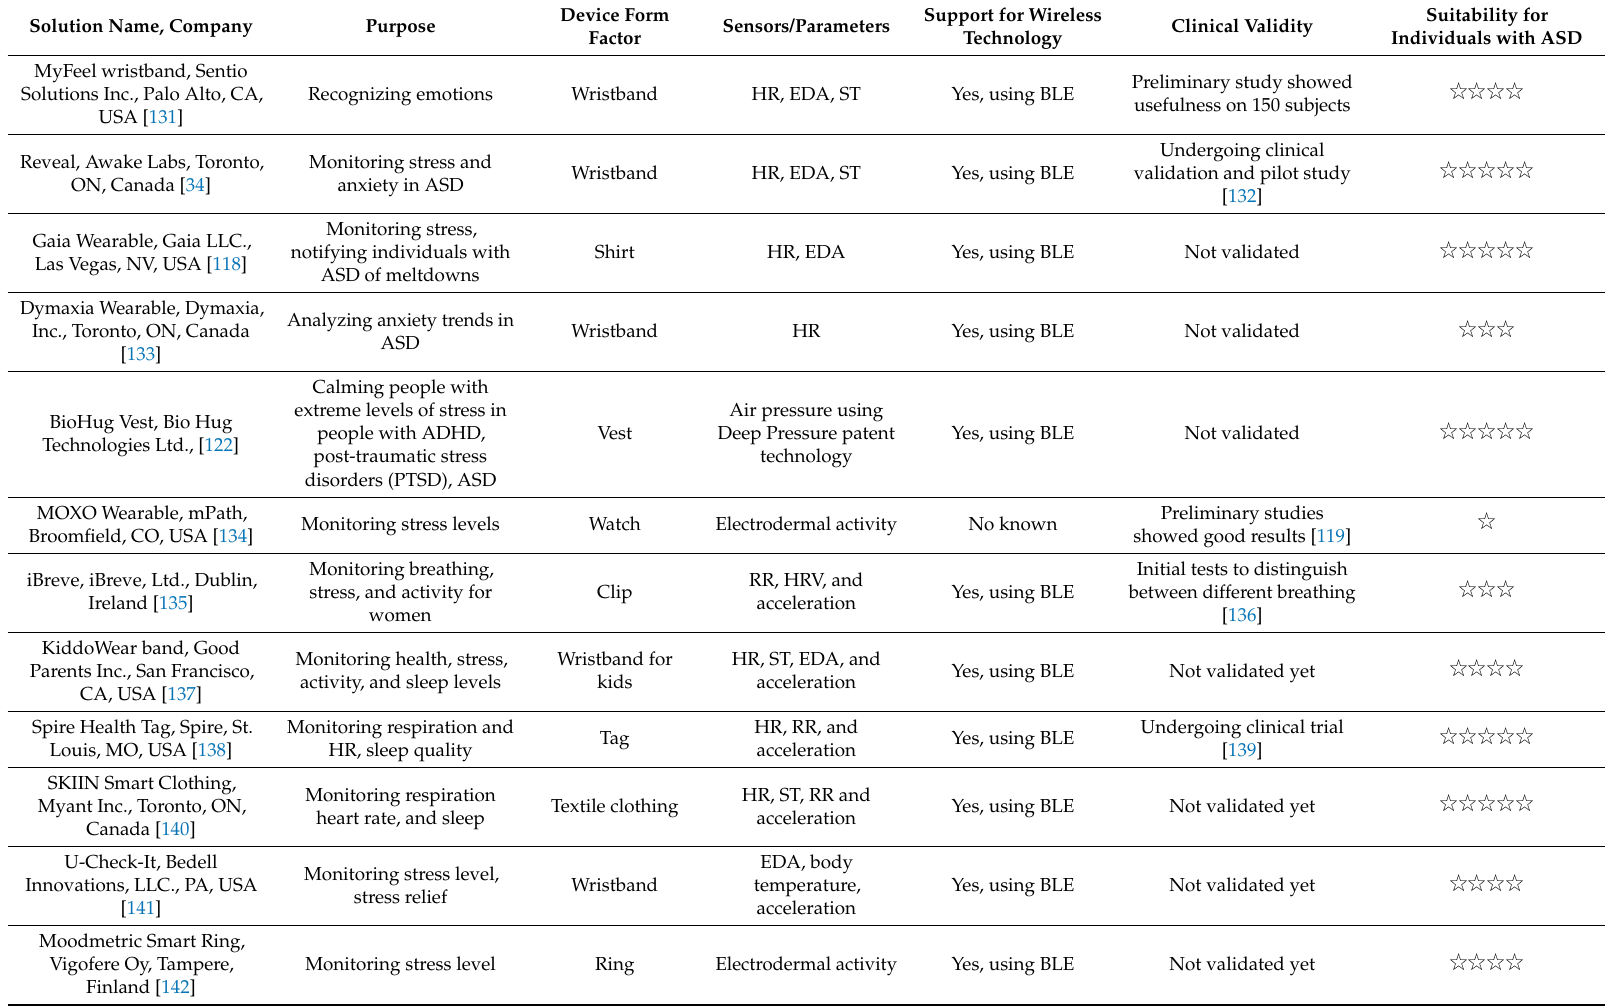
Table 3. Comparison of emerging solutions for emotional